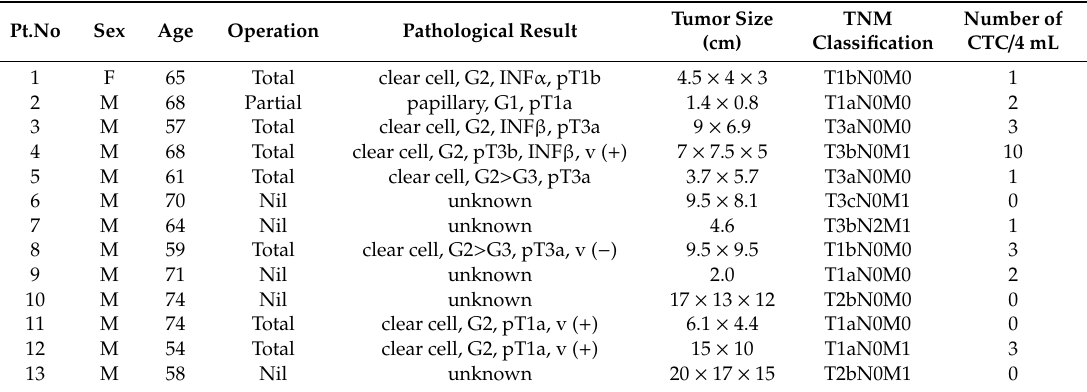
Table 1. Clinicopthologic profiles and detected CTCs in 4 ml of peripheral blood samples from RCC patients.